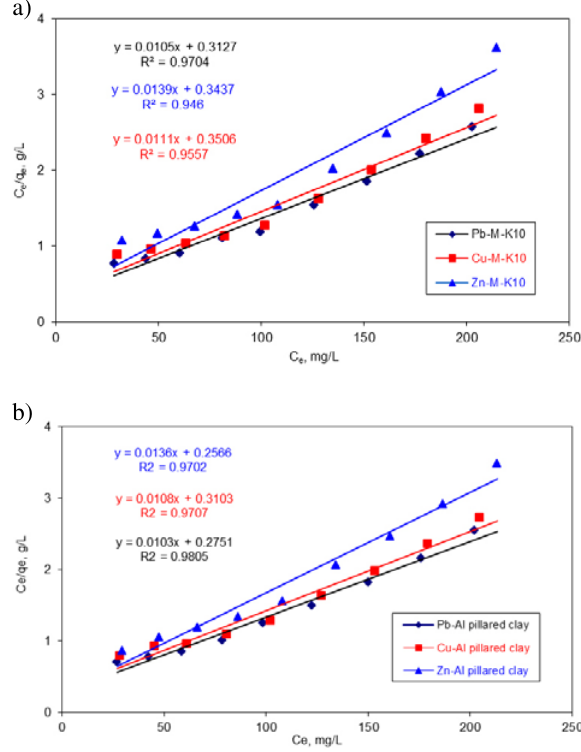
Fig. 6. Langmuir adsorption isotherms: montmorillonite – K10 (a), Al-pillared clay